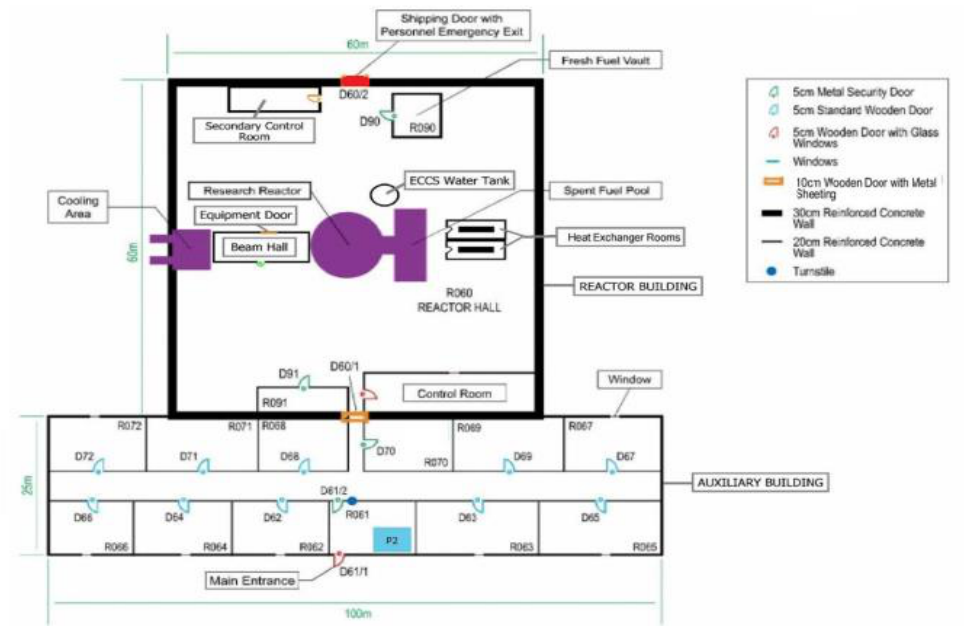
Figure 4. MTR building floor plan as described in the data